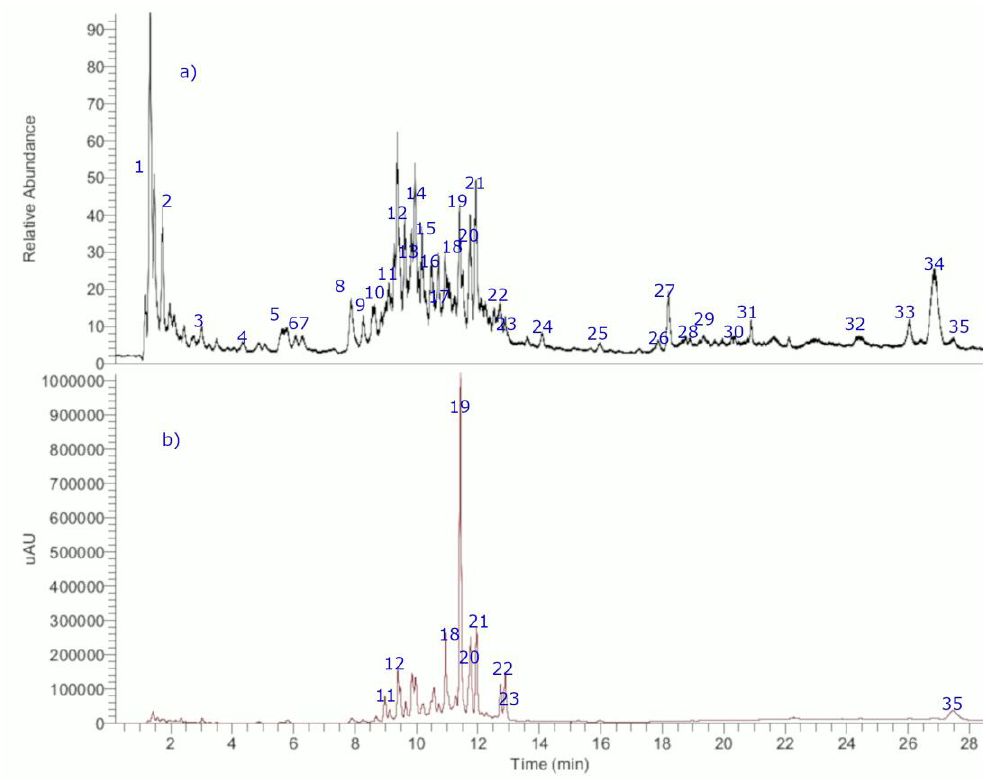
Figure 2. UHPLC chromatrograms of Mulinum crassifolium : ( a ) total ion current spectra; and ( b ) UV vis spectra at 280 nm.